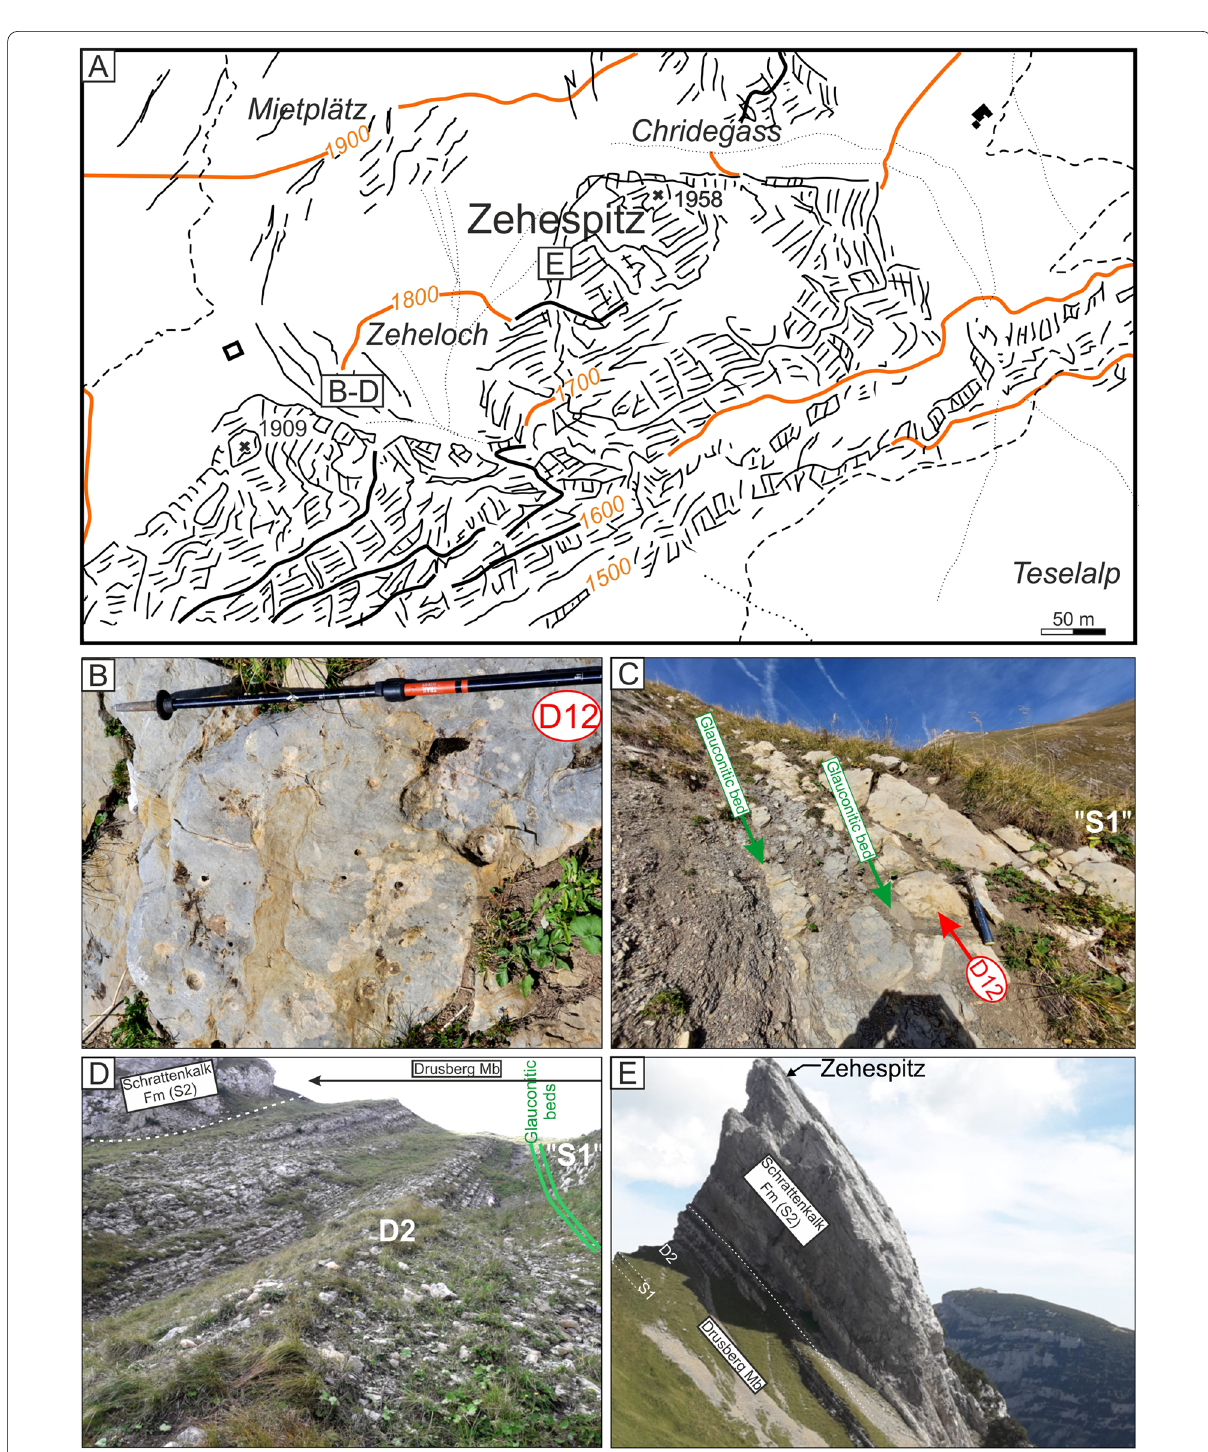
Fig. 13 A Locality map of the Zeheloch section and photographs of the Drusberg Member. B Bioturbated firmground (D12) in the middle of the Drusberg Member. C Glauconite-rich Chopf Bed topping the firmground (D12). D Focus on the upper Drusberg unit D2. E View on the Drusberg-Schrattenkalk transition at